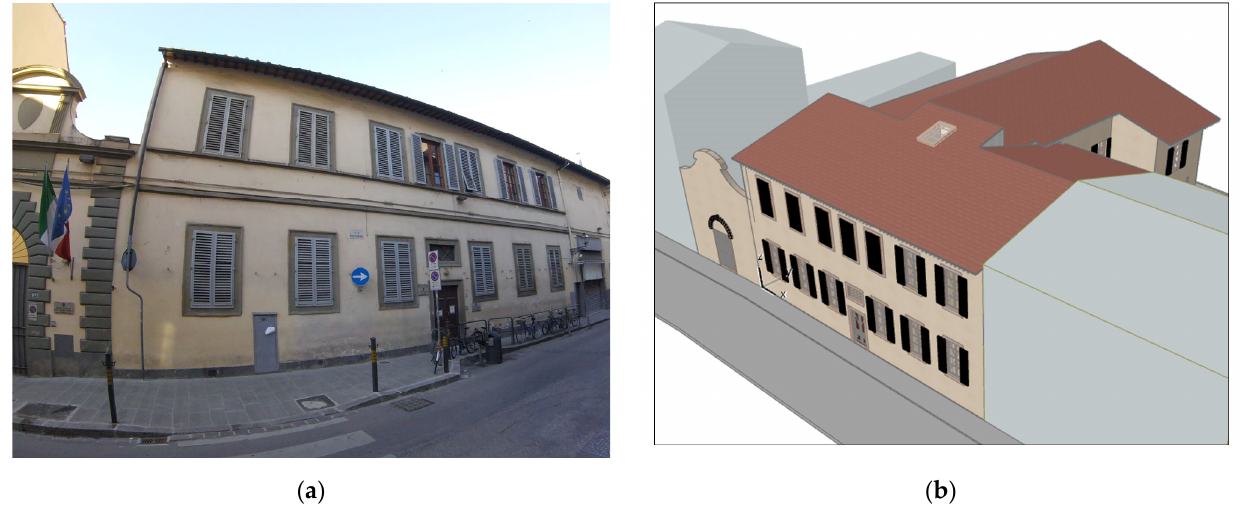
Figure 3. “Bernardo Rucellai” school: ( a ) a fish-eye photo of the façade; ( b ) Building Information Model of the school.